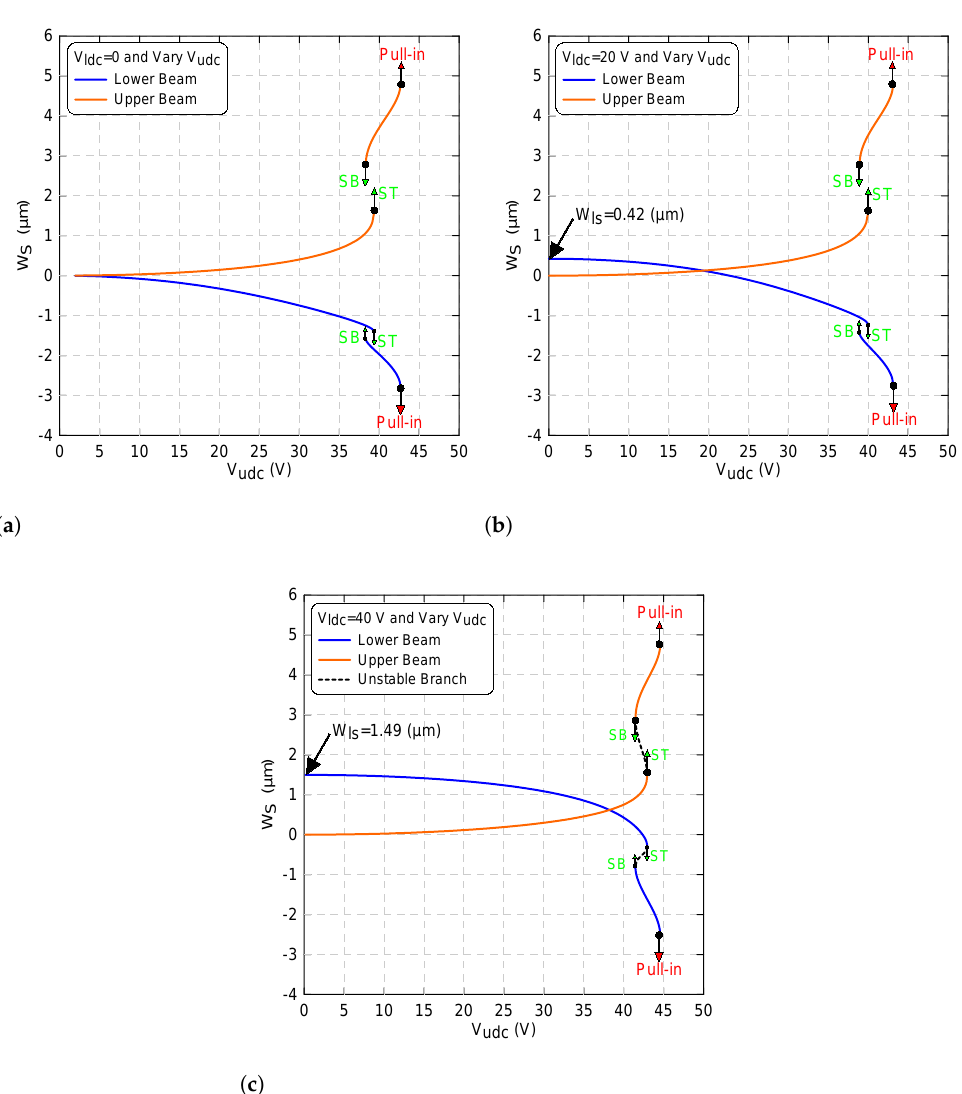
Figure 8. The beam mid-point deflections of the lower beam w ls ( 0.5 ) and of the upper beam w us ( 0.5 ) as a function of the upper static voltage using three-symmetric modes ROM and a lower voltage sets to: ( a ) V ldc = 0, ( b ) V ldc = 20 V and ( c ) V ldc = 40 V. The stable static equilibria of the lower beam are marked with blue lines, the stable static equilibria of the upper beam are marked with orange lines whereas the unstable static equilibria are marked with dashed black